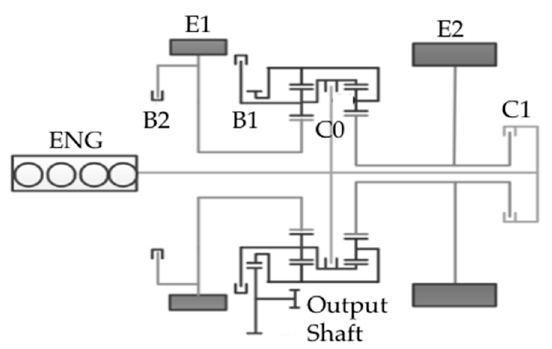
Figure 1. The structure diagram of the compound power-split system. The equivalent lever of the compound power-split system is shown in Figure